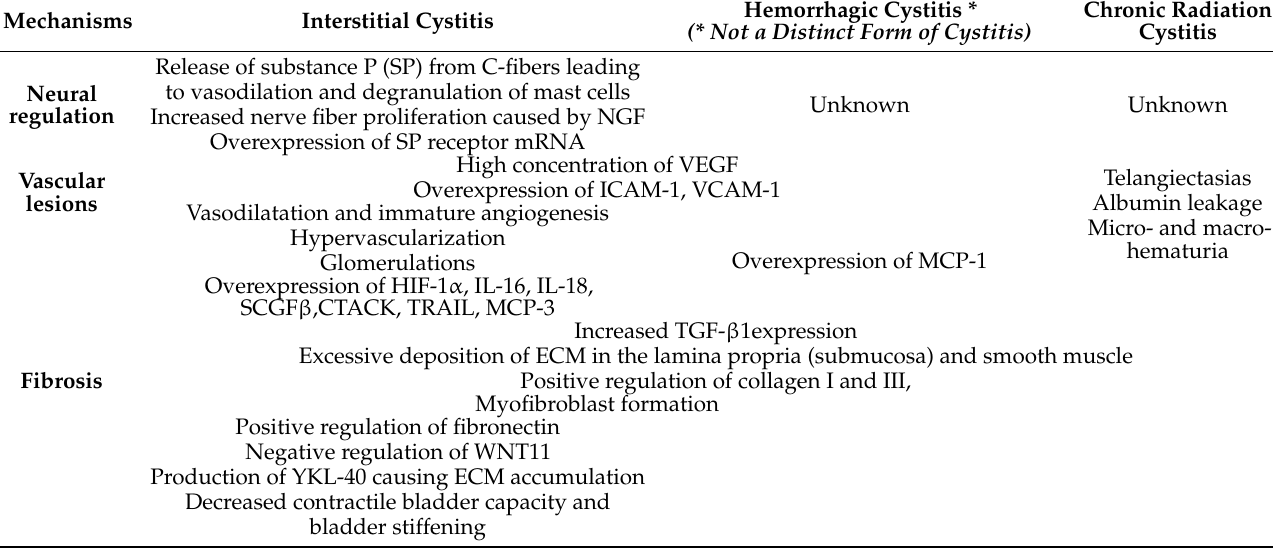
Table 3. Pathophysiological mechanisms: Neural regulation, vascular lesions and